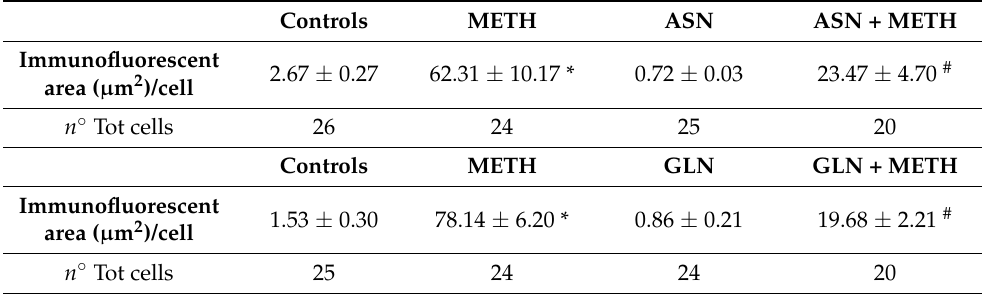
Table 1. LC3 immunofluorescent areas within the ventral tier neurons of the SNpc. Controls METH ASN ASN + METH